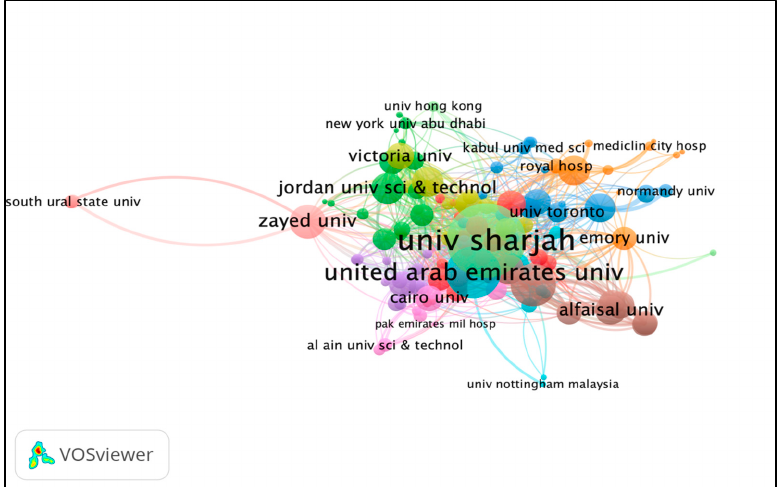
Figure 5. Co-authorship organizations network visualization based on TLS. Different colors represent different clusters, while the nodes represent the contribution of an organization, and the links represent the linkage/collaboration between organizations. The bigger the node, the higher contribution of an organization; the thicker the linkage/line, the stronger the collaboration between organizations.